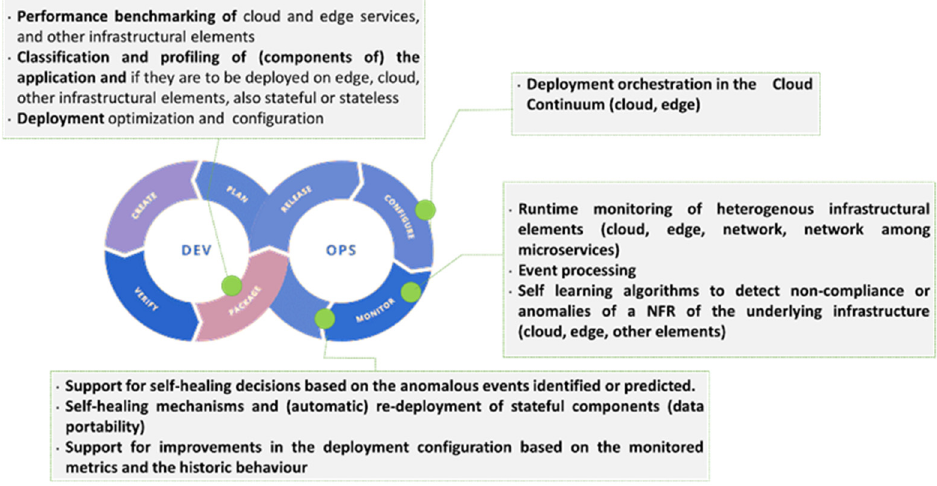
Figure 1. Challenges in the Operationalization (Ops) of applications in the Cloud Continuum .